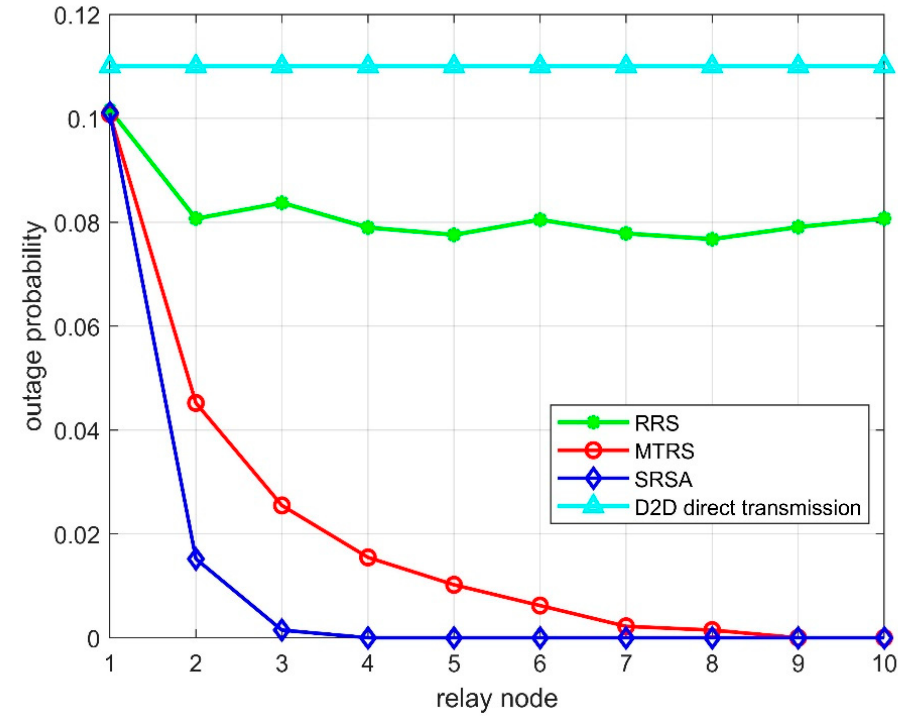
Figure 4. The relationship between the system outage probability and the number of relays.